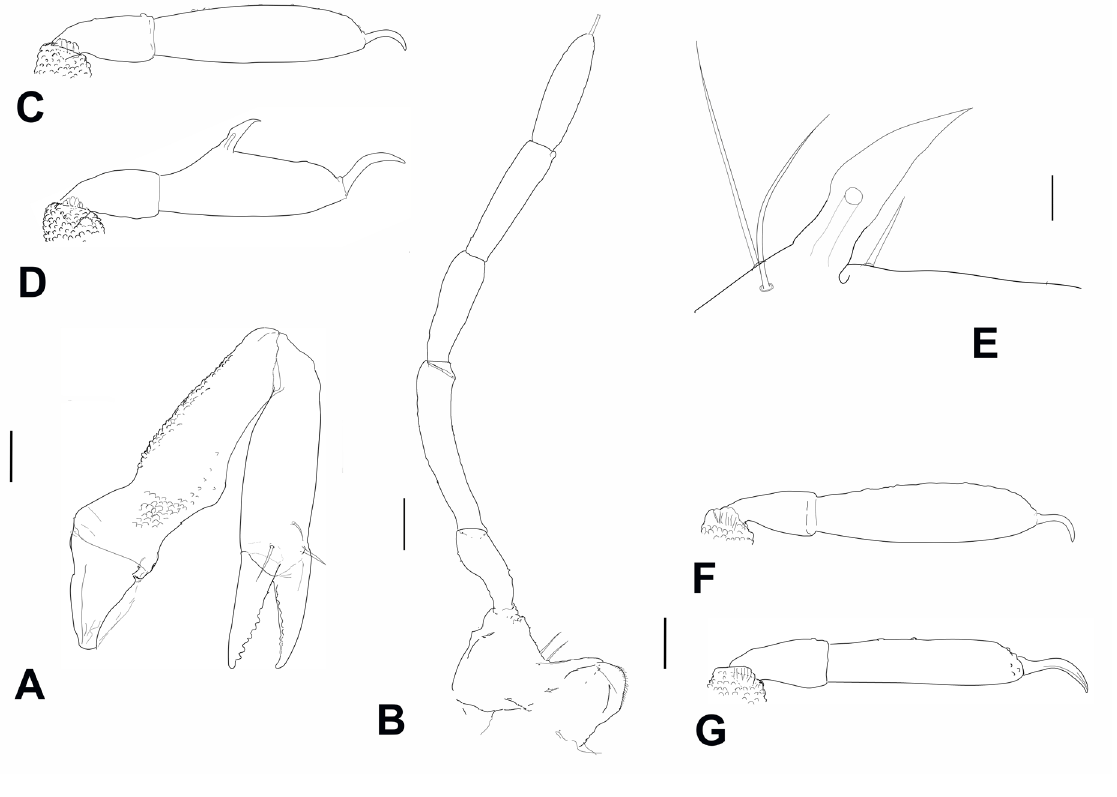
Fig. 5. Siro franzi Karaman & Raspotnig sp. nov. A–E . Paratype, ♂ (IKC1538). F–G . Paratype, ♀ (NHMW 28759). A . Chelicerae, medial view. B . Pedipalp, medial view. C . Basitarsus and telotarsus, leg I. D . Basitarsus and telotarsus, leg IV. E . Adenostyle. F . Basitarsus and telotarsus, leg I. G .